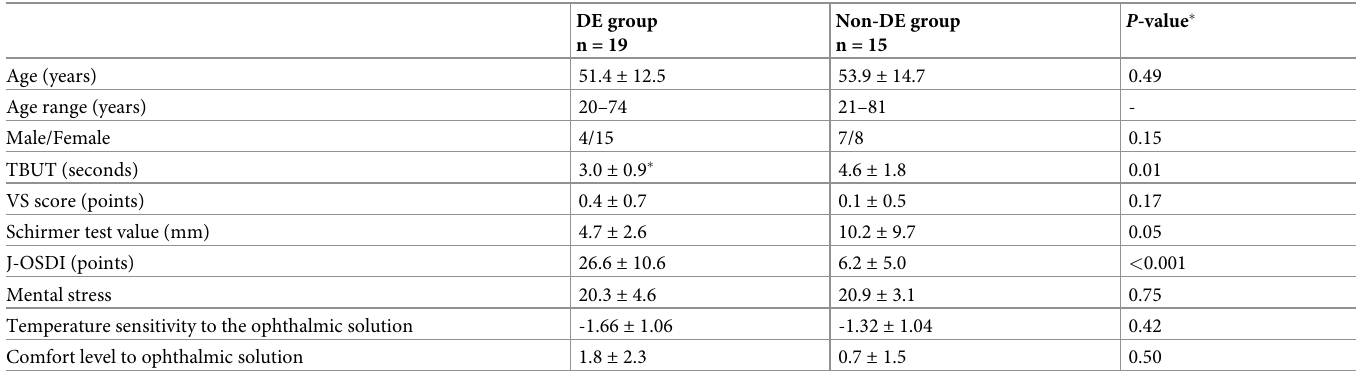
Table 1. Demographics of the study